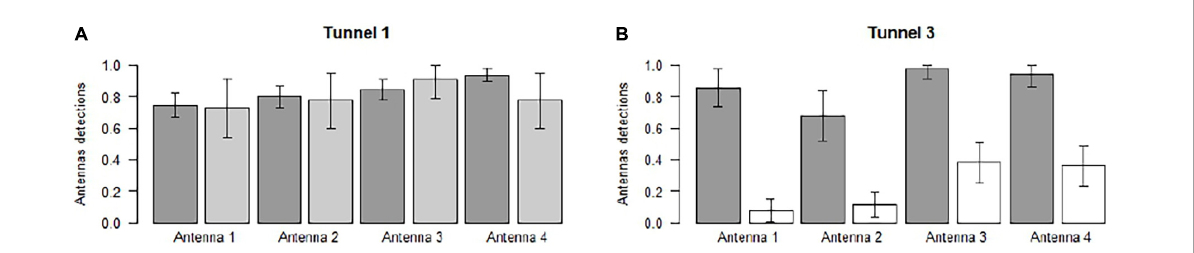
FIGURE2 Effectiveness of the antennas correspond to the proportion of animals detected by the antenna among the animals that completely crossed the tunnels. Antenna effectiveness was measured in Tunnel 1 (A) and Tunnel 3 (B) . Dark gray bars represent T. cristatus , light gray bars represent S. salamandra , and white bars represent Pelophylax